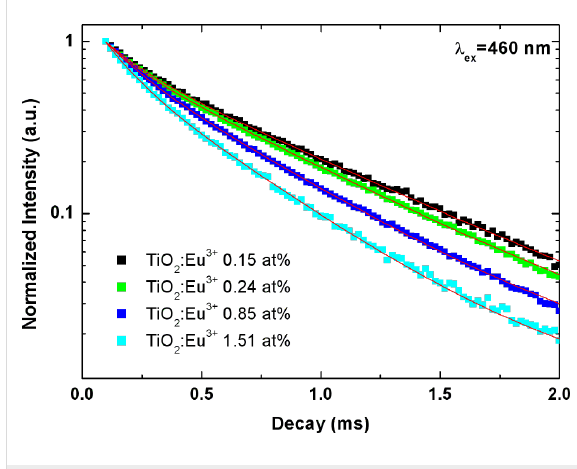
Figure 5: Decay of the TiO 2 :Eu emission intensity with time for excita- tion at 330 nm.